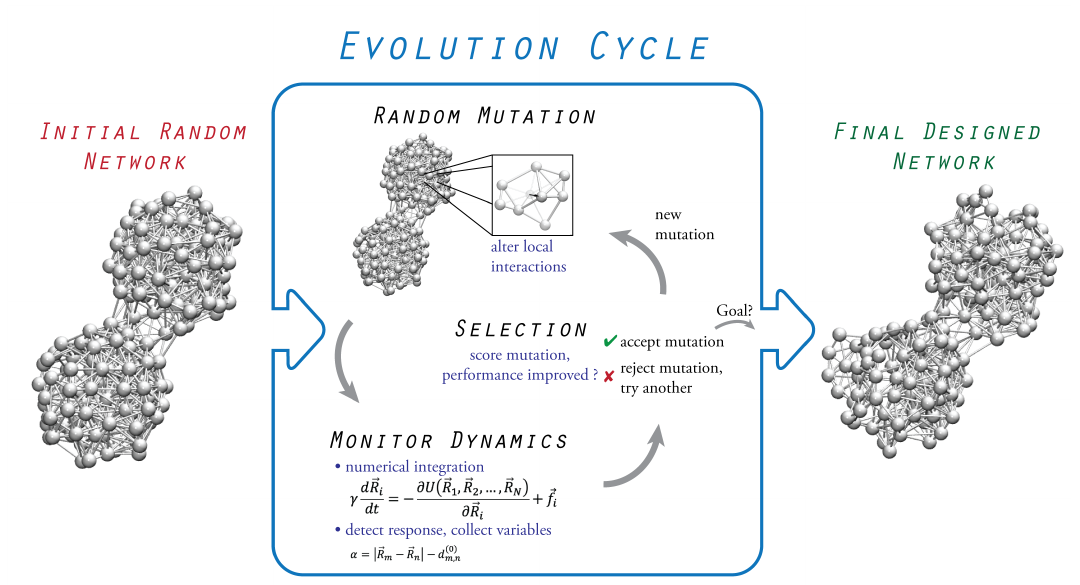
Figure 1. Design scheme of evolutionary optimization. Starting from an inactive random elastic network, functional elastic networks are designed within a cycle of in silico evolution. A sequence of mutation followed by selection is iteratively applied to the network to improve its performance towards the intended prescribed